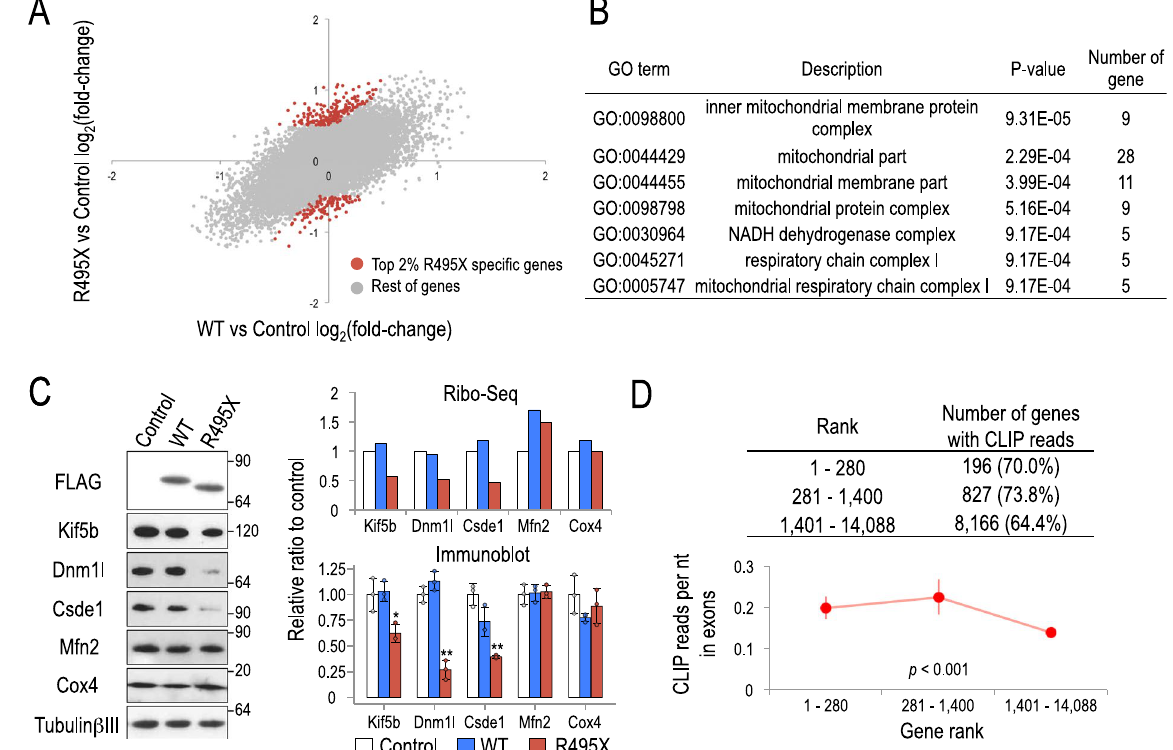
Figure 4. Differential gene translation analysis for WT- and R495X-expressing neurons. ( A ) Scatter plot of WT versus control and R495X versus control differential gene translation. The top 2% (280) differentially translated genes that are specific to R495X are shown in red. ( B ) Gene ontology enriched terms for the top 2% (280) differentially translated genes specific to R495X compared to the remaining genes. ( C ) Immunoblots of differentially translated genes in R495X-expressing neurons (left). Bar plots for gene translational levels quantified from Ribo-Seq (top right) and protein band intensities quantified from immunoblots (bottom right). Protein standard is shown on the right. Band intensities were normalized by Tubulin β III and the average value for control was set to 1. P-values in one-way ANOVA are, 0.01, < 0.0001, 0.001, 0.725 and 0.257 for Kif5b, Dnm1l, Csde1, Mfn2 and Cox4, respectively. * p < 0.05, ** p < 0.01 to control in post Tukey’s HSD test. Error bar indicates standard deviation (N = 3). ( D ) Number of genes that are bound by R495X for gene sets of decreasing differential translation in R495X (top) and R495X binding density in gene exons for the same gene sets (bottom). Error bars indicate standard error. P-value, one-way ANOVA